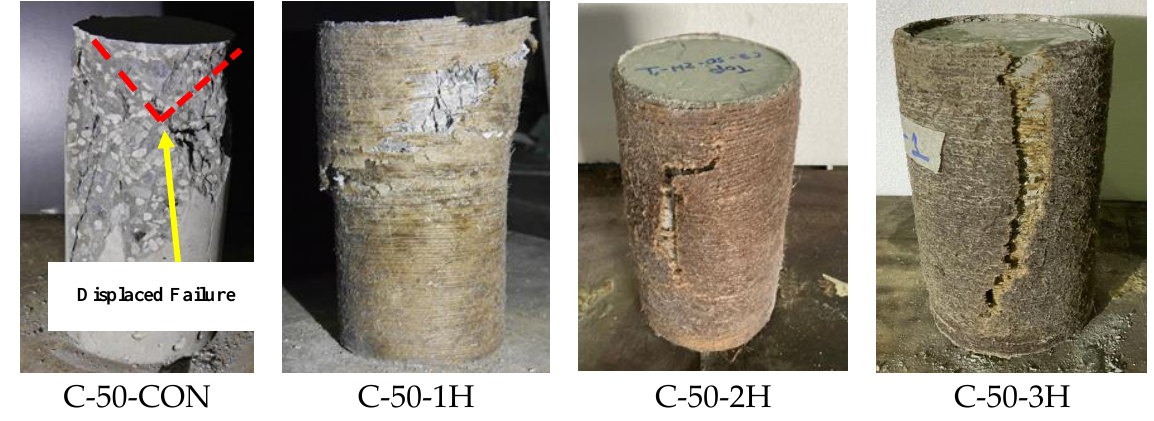
Figure 6. Failure modes of concrete prisms (Group 2).